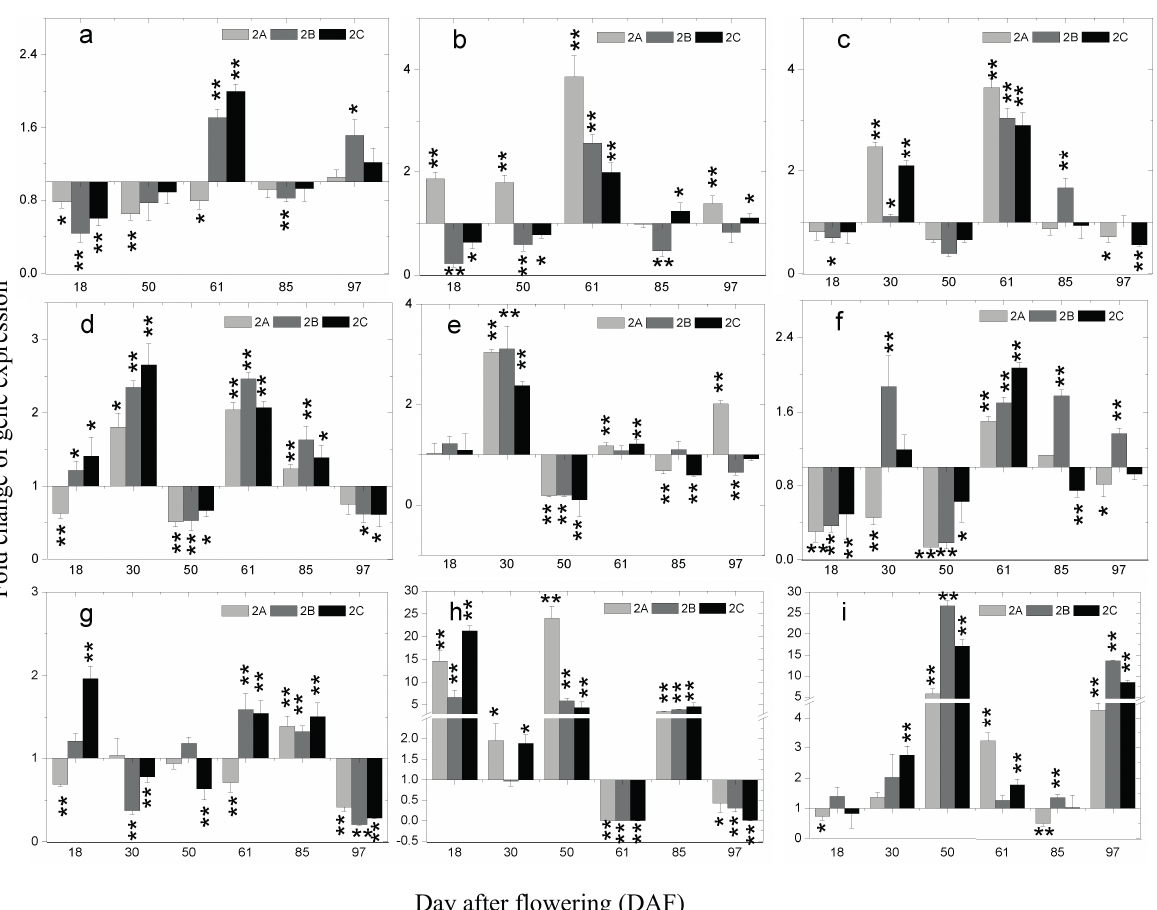
Figure 7. Fold changes of gene expression between the Zn-treated groups and the control at 6 developmental stages of Merlot grape berry of 2013. ( a ) VvPAL ; ( b ) VvSTS29 ; ( c ) VvCHS ; ( d ) VvCHI ; ( e ) VvF3H ; ( f ) VvFLS4 ; ( g ) VvDFR ; ( h ) VvLDOX ; ( i ) VvMYBF1 . To